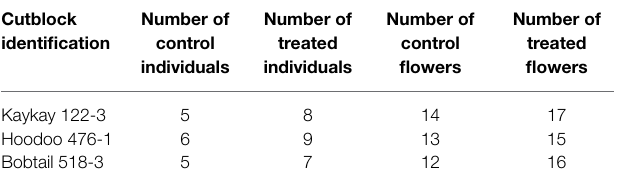
TABLE 2 | Summary of R. acicularis flower collection, for morphological assessment in 2019, from areas treated with GBH treated and control areas 1 year prior (August 2018) in British Columbia,